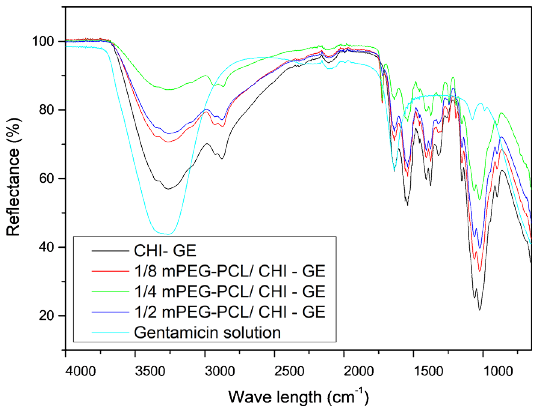
Figure 4. Infrared spectra of membranes: (black) CHI-GE, (red) 1/8 mPEG-PCL/CHI-GE, (green) 1/4 mPEG-PCL/CHI-GE, (blue)